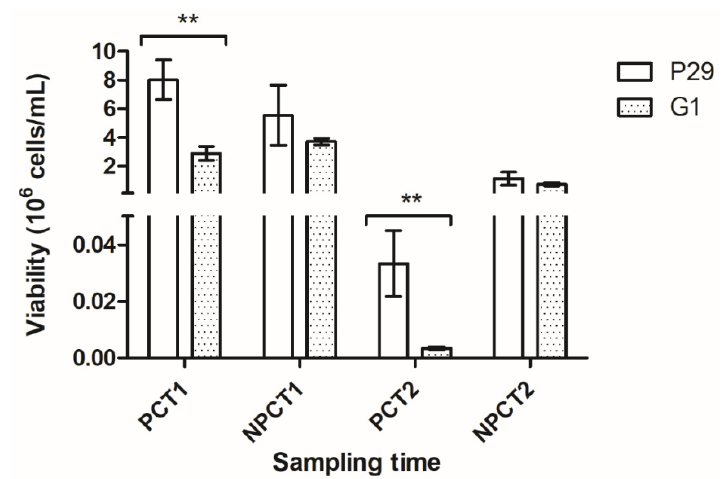
Figure 2. Cell viability (cells / mL) observed in both S. cerevisiae yeast strains P29 and G1 under PC (CO 2 pressure condition) and NPC (non-CO 2 pressure condition), in each sampling time: at the middle of the secondary fermentation (T1) and 1 month after the secondary fermentation (T2). Error bars represent the standard deviation of the three independent experiments. Significant di ff erences from One-way ANOVA analysis are indicated by *, depending on the significance level (* < 0.05; ** < 0.01).